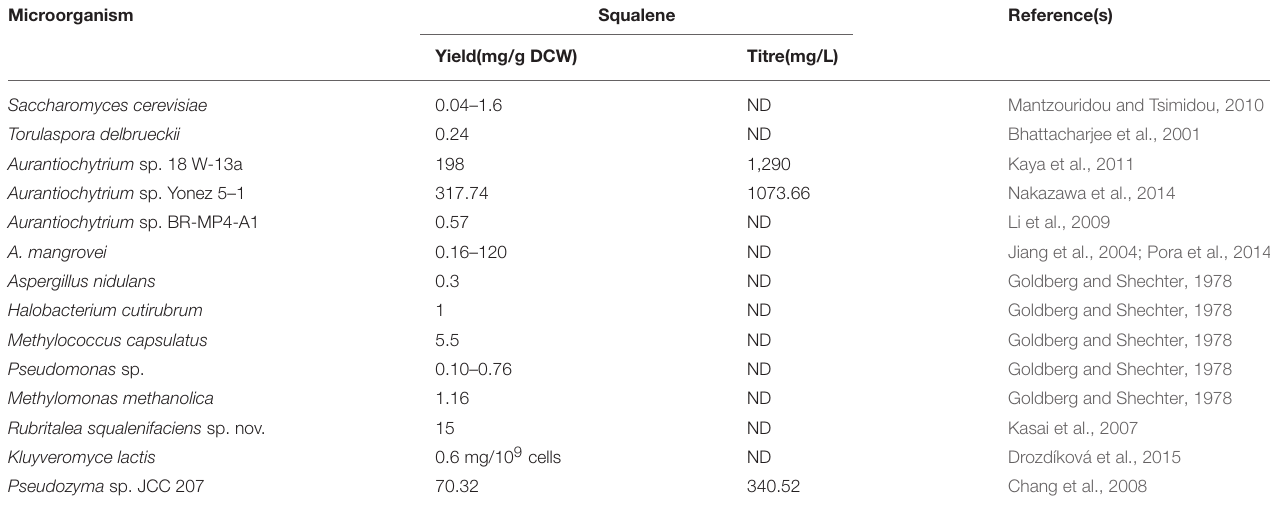
TABLE 2 | Wild-type microorganisms as a source of